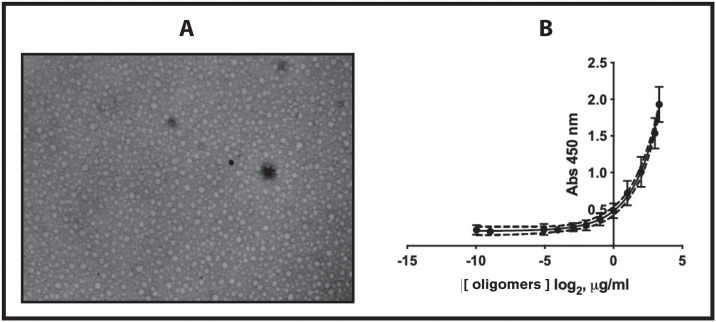
Standard curves of the new anti-hIAPP cytotoxic oligomer antibody’s reactivity to synthetic hIAPP cytotoxic oligomers.A). Representative negative stain TEM images of synthetic, spherical and cytotoxic oligomers of hIAPP used in the standard curves. B). The standard curves (n = 6) of polyclonal antibody reactivity to synthetic hIAPP cytotoxic oligomers were used to interpolate the hIAPP homo- and hetero-oligomer concentrations in the PTS of sera of children with obesity, type 1 diabetes and type 2 diabetes vs healthy children. R squared = 0.9524.